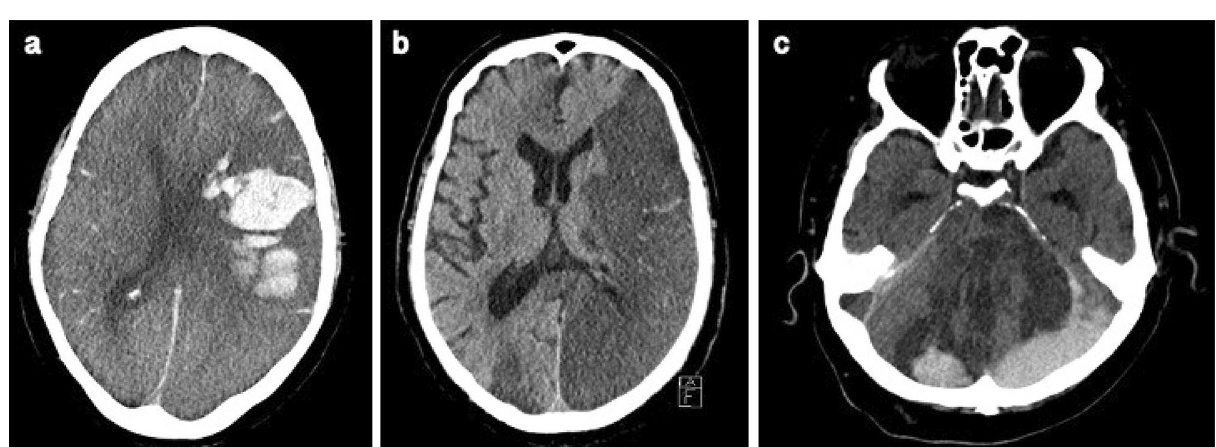
Figure 5. Acute PNIF on Brain CT in three exemplary cases. ( a ) Case 1. Lobar hemorrhage in the left hemisphere and global subarachnoid hemorrhage with secondary intraventricular hemorrhage. ( b ) Case 8. Multiple, presumably embolic, infarcts in multiple cerebral circulations (left MCA, right ACA, PCA bilateral, cerebellum). ( c ) Case 12. Intracranial hemorrhage after multiple infarcts (PCA bilateral, brainstem